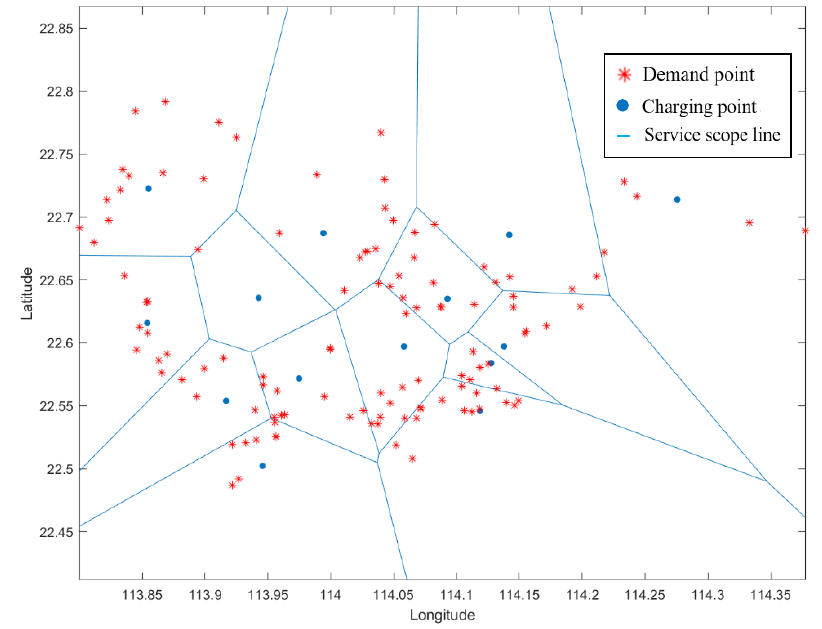
Figure 26. Using a Voronoi diagram to divide the service scope of charging stations.